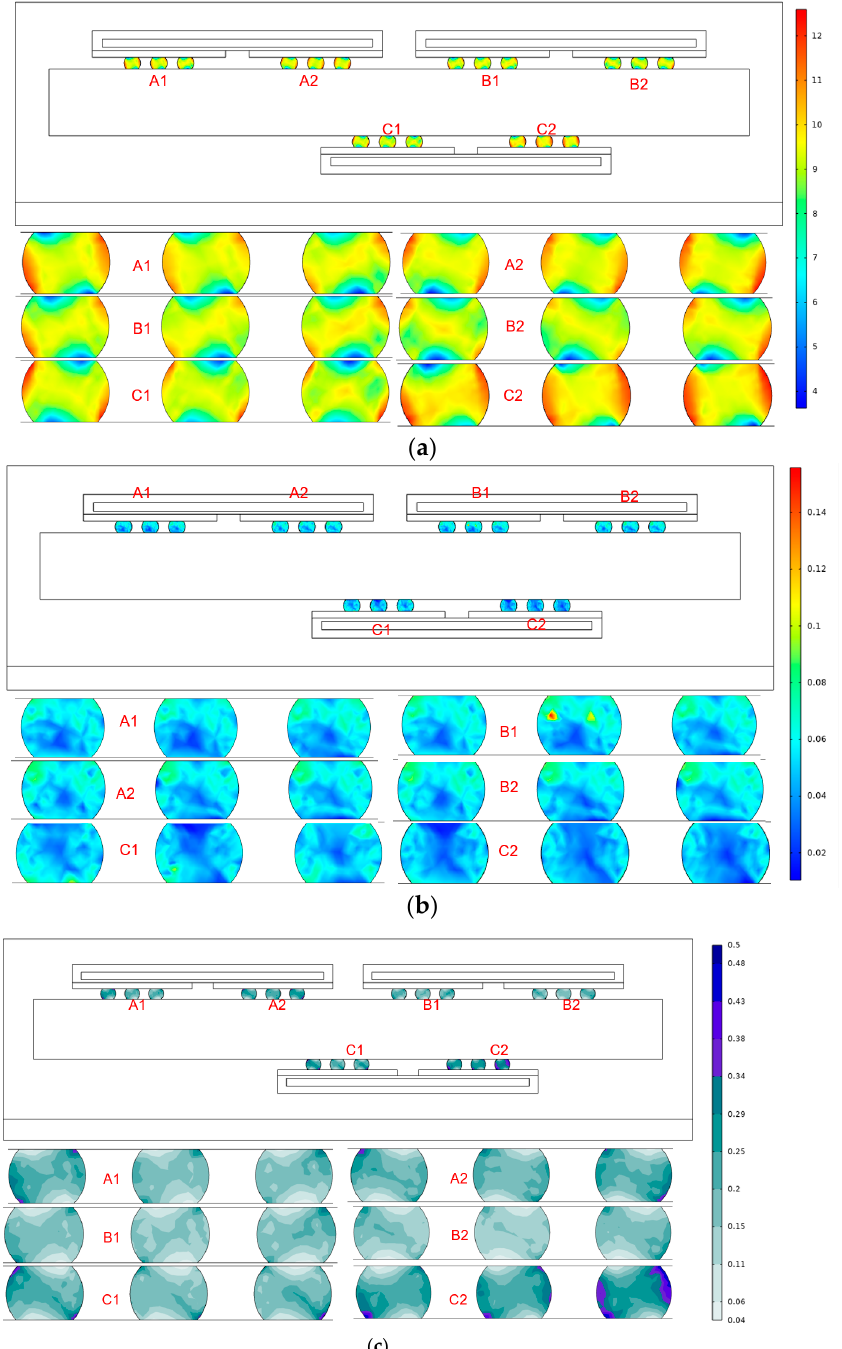
Figure 7. Contour maps of the von Mises stress and Creep strain of the solder joint under thermal shock. ( a ) von Mises stress at − 55 °C; ( b ) von Mises stress at 125 °C; ( c ) creep strain.